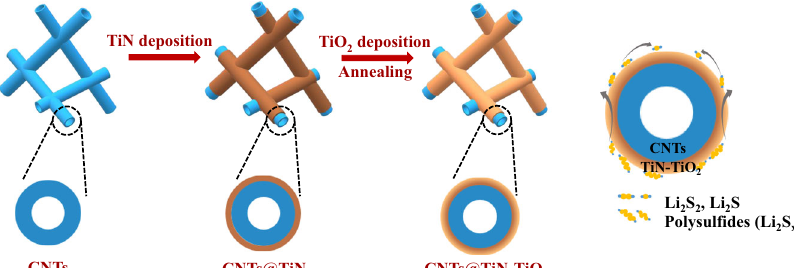
Fig. 1 Schematic illustration showing the fabrication process of CNTs@TiN – TiO 2 and its catalytic process for the polysul fi de conversion. Through the ALD method, TiN and TiO 2 are deposited sequentially on the CNTs surface, and then the obtained hybrid is annealed to be transformed into the coaxial CNTs@TiN-TiO 2 sponge with uniform distribution of the TiN – TiO 2 heterostructure. With the help of the TiN – TiO 2 heterostructure, the conversion process from lithium polysul fi des to Li 2 S 2 /Li 2 S occurs smoothly in two steps of adsorption and catalytic